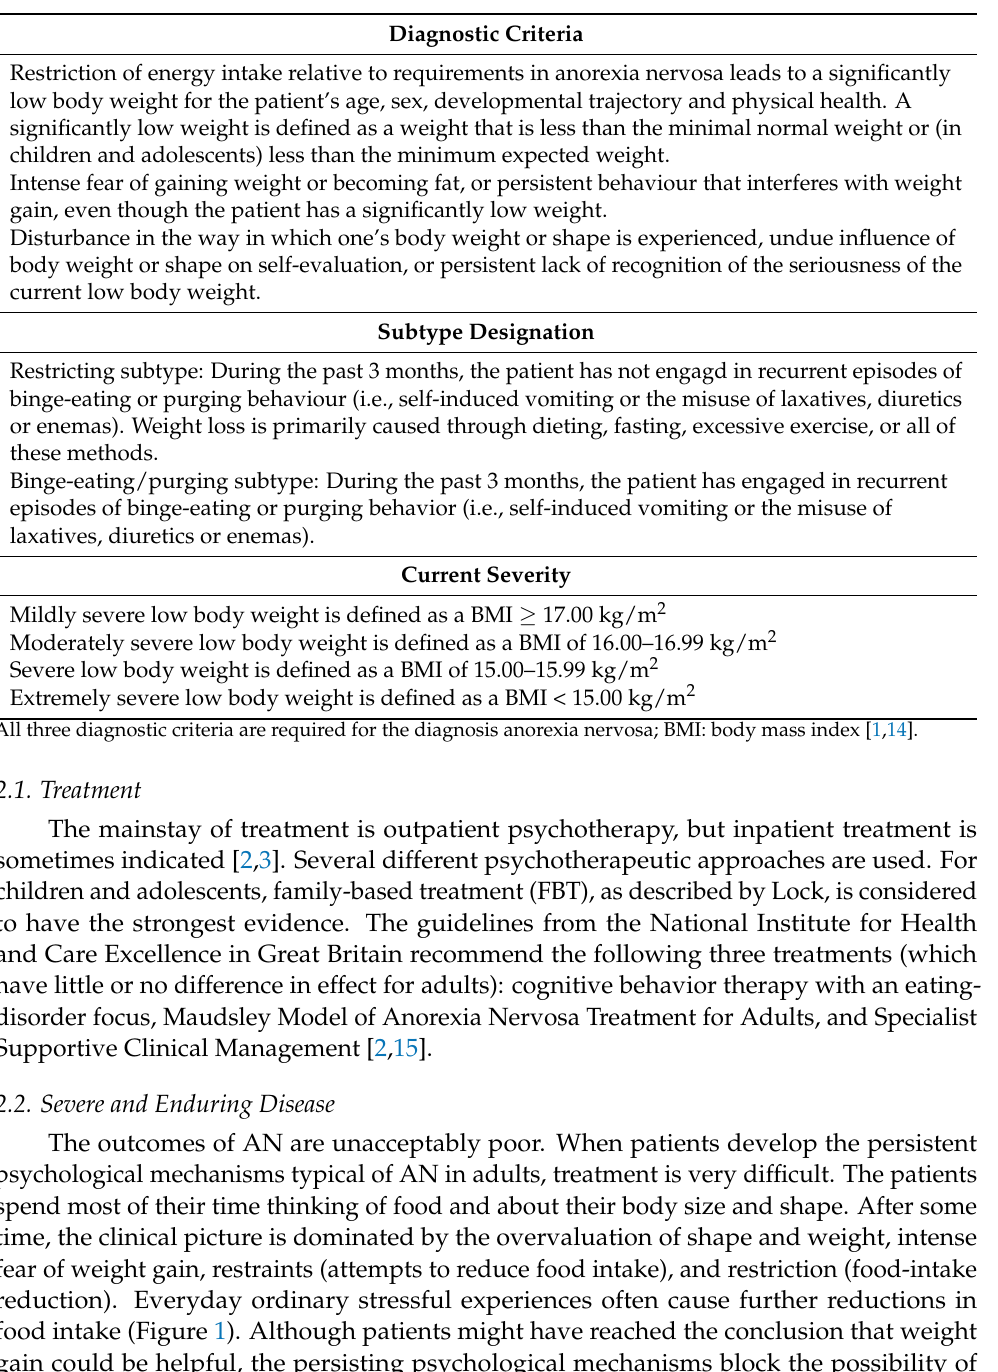
Table 1. Diagnostic criteria, subtypes and severity of anorexia